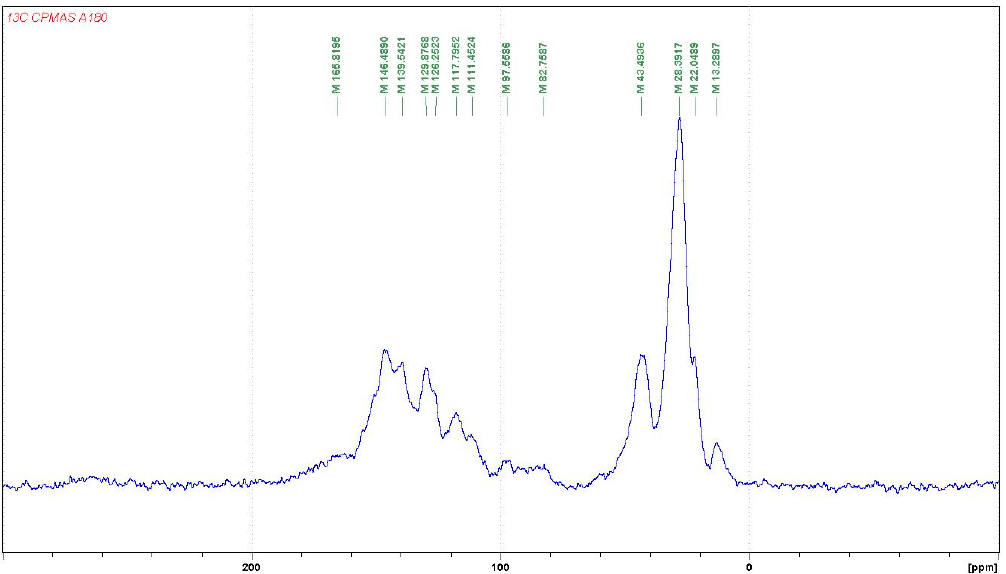
Figure 16. Cross-polarisation/magic-angle spinning (CP-MAS) 13 C NMR spectrum of the reaction of catechin with hexamethylene diamine at 185 °C, p -toluenesulfonic acid (pTSA)-catalysed.